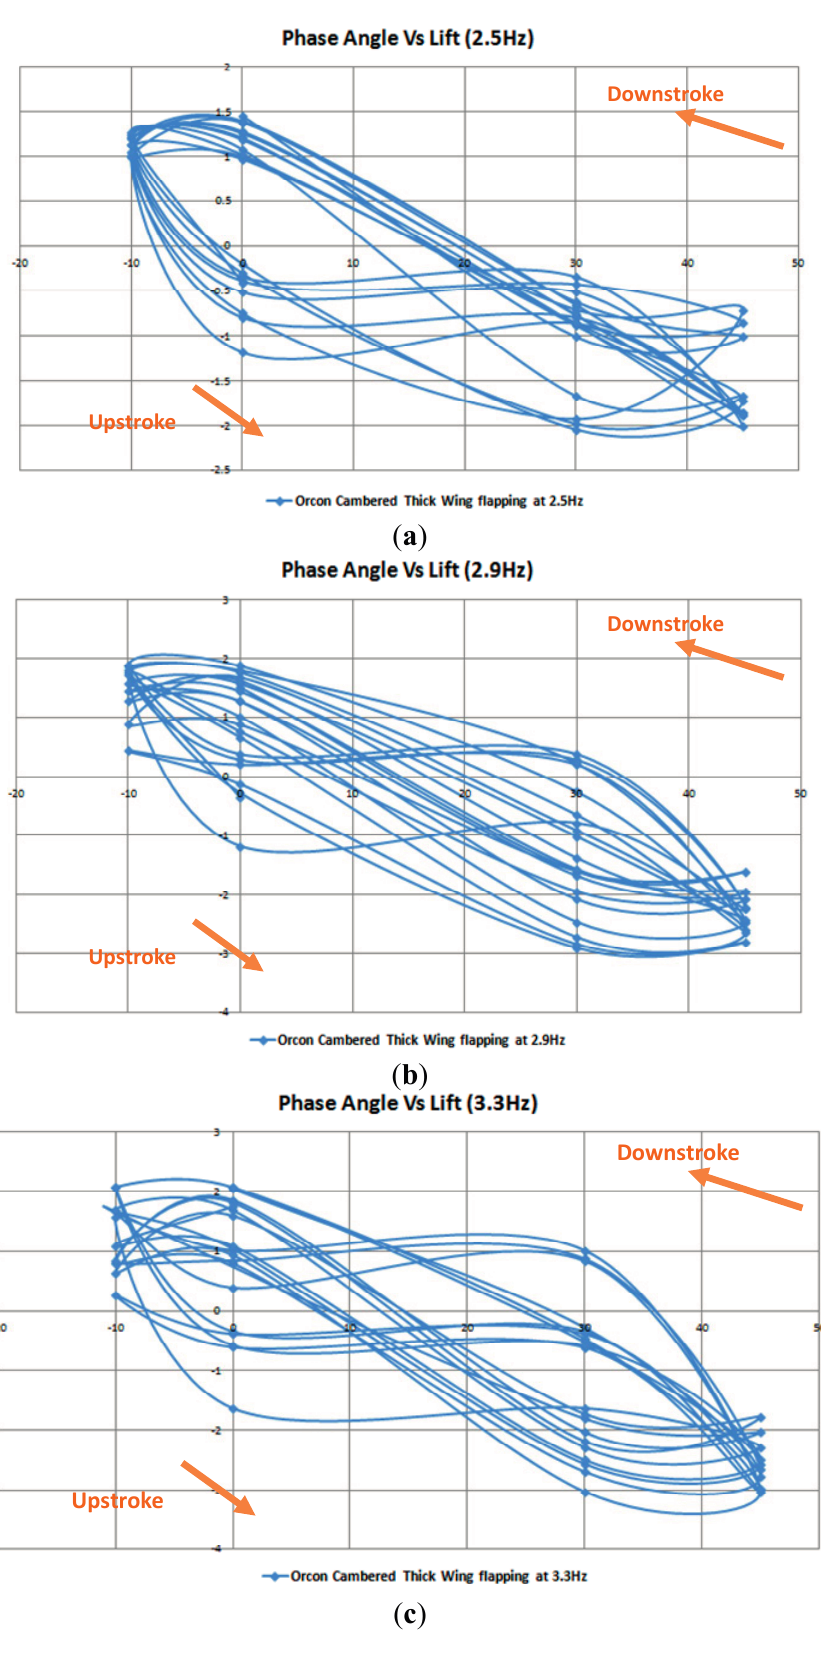
Figure 43. Phase angle vs . lift for Orcon cambered thick wing. ( a ) Low speed; ( b ) medium speed; ( c ) high